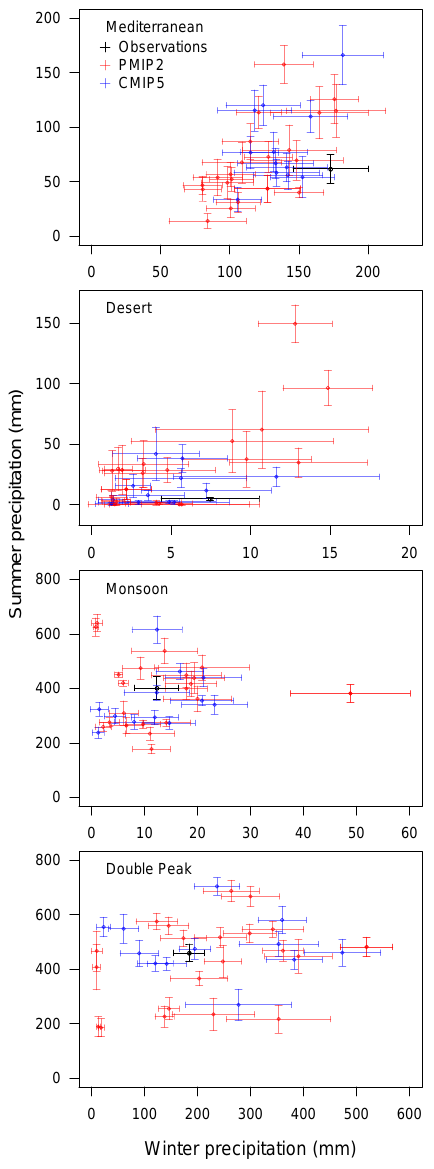
Fig. 8. Comparison of simulated and observed summer and win- ter precipitation in each of the four precipitation regimes (Mediter- ranean, Desert, Monsoon, Double Peak). The observations (black) are the average for the period 1961–1990 from the CRU T3.1 data set (Harris et al., 2014). The simulated mean and standard deviation of precipitation from the CMIP5 models (blue) is based on the last 100yr of the piControl . These simulations can be compared with re- sults from coupled ocean–atmosphere simulations made during the second phase of the PMIP2 (Braconnot et al., 2012; shown in red). The PMIP2 results are the mean and standard deviation based on the last 100yr of a piControl , except in three cases where only 50yr of data were available. Model results are calculated for each precipita- tion regime based on the observed geographic extent characterized by these regimes, as defined using the CRU TS3.1 data set. Summer and winter as defined in Sect.